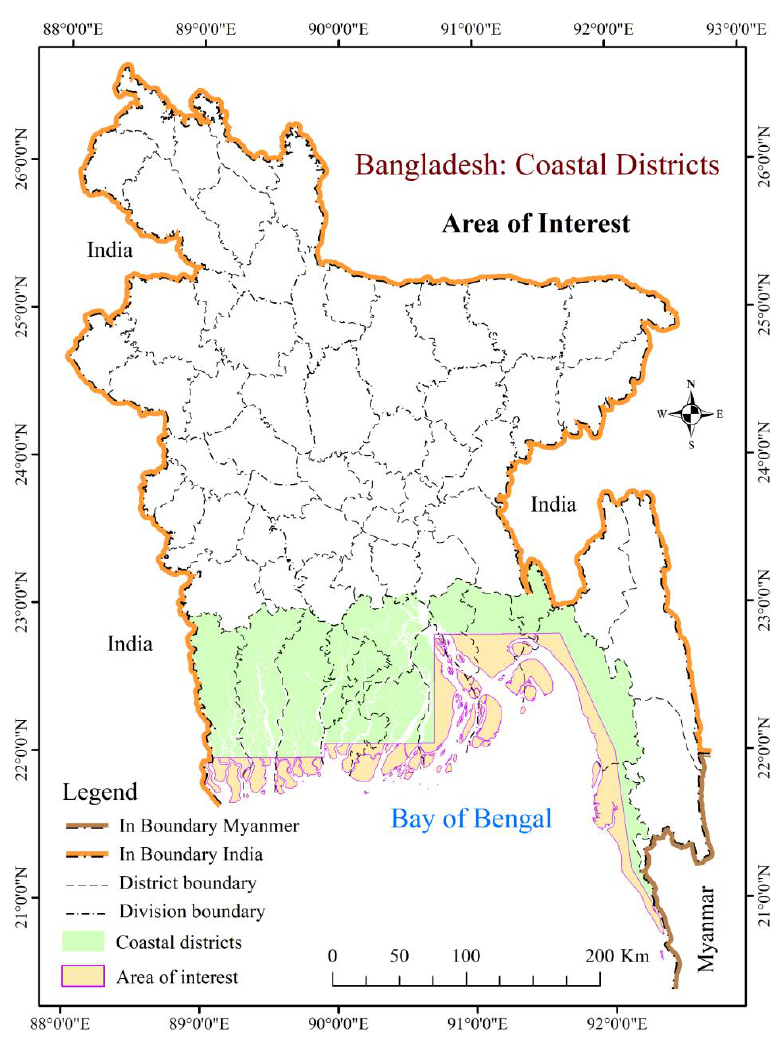
Figure 2. The study area (Datum WGG84): total 14 coastal districts and area of interest (AoI).